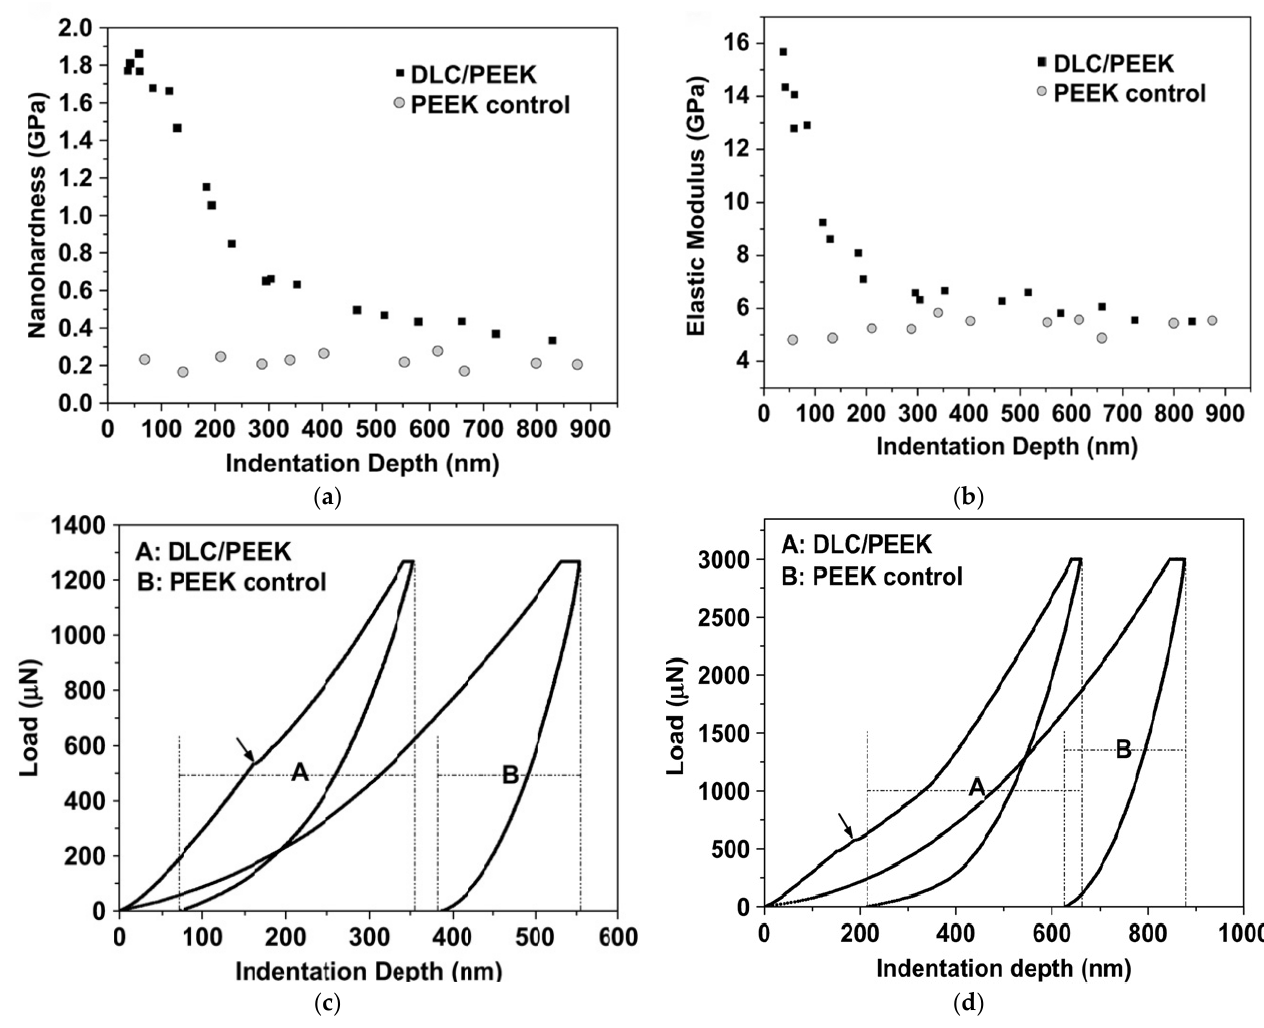
Figure 3. Nanohardness, elastic modulus and load-displacement curves of DLC/PEEK and PEEK control. ( a ) Nanohardness and ( b ) elastic modulus of DLC/PEEK and PEEK control as a function of indentation depth. Comparison of load-displacement curves of DLC/PEEK and PEEK control at the peak indentation load at ( c ) 1300 mN and ( d ) 3000 mN. (Black arrows: ring-like through-thickness cracking) (Reproduced from [22], with permission from © 2010 Elsevier).